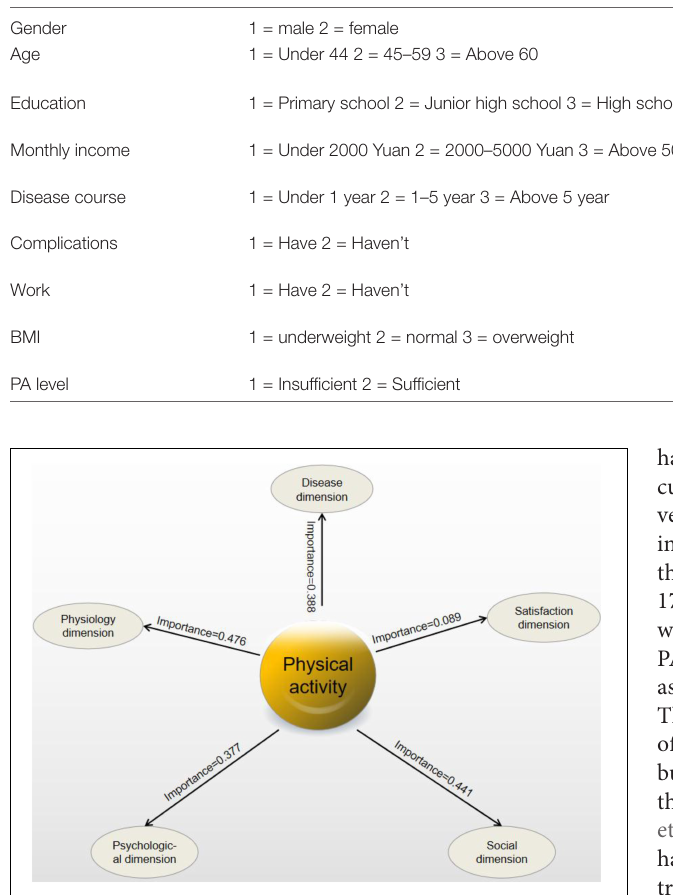
TABLE 5 | Optimal regression analysis of PA on total QoL score. Independent variable